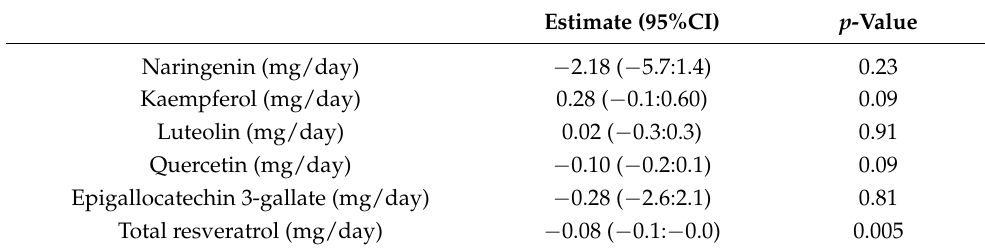
Table 4. Quantile regression models. Polyphenols consumed daily at baseline according to follow-up incident hip fracture. Data were reported as differences of the median estimates and 95%CI. All p -values were age- and sex-adjusted. The reference group was represented by subjects without hip fracture.